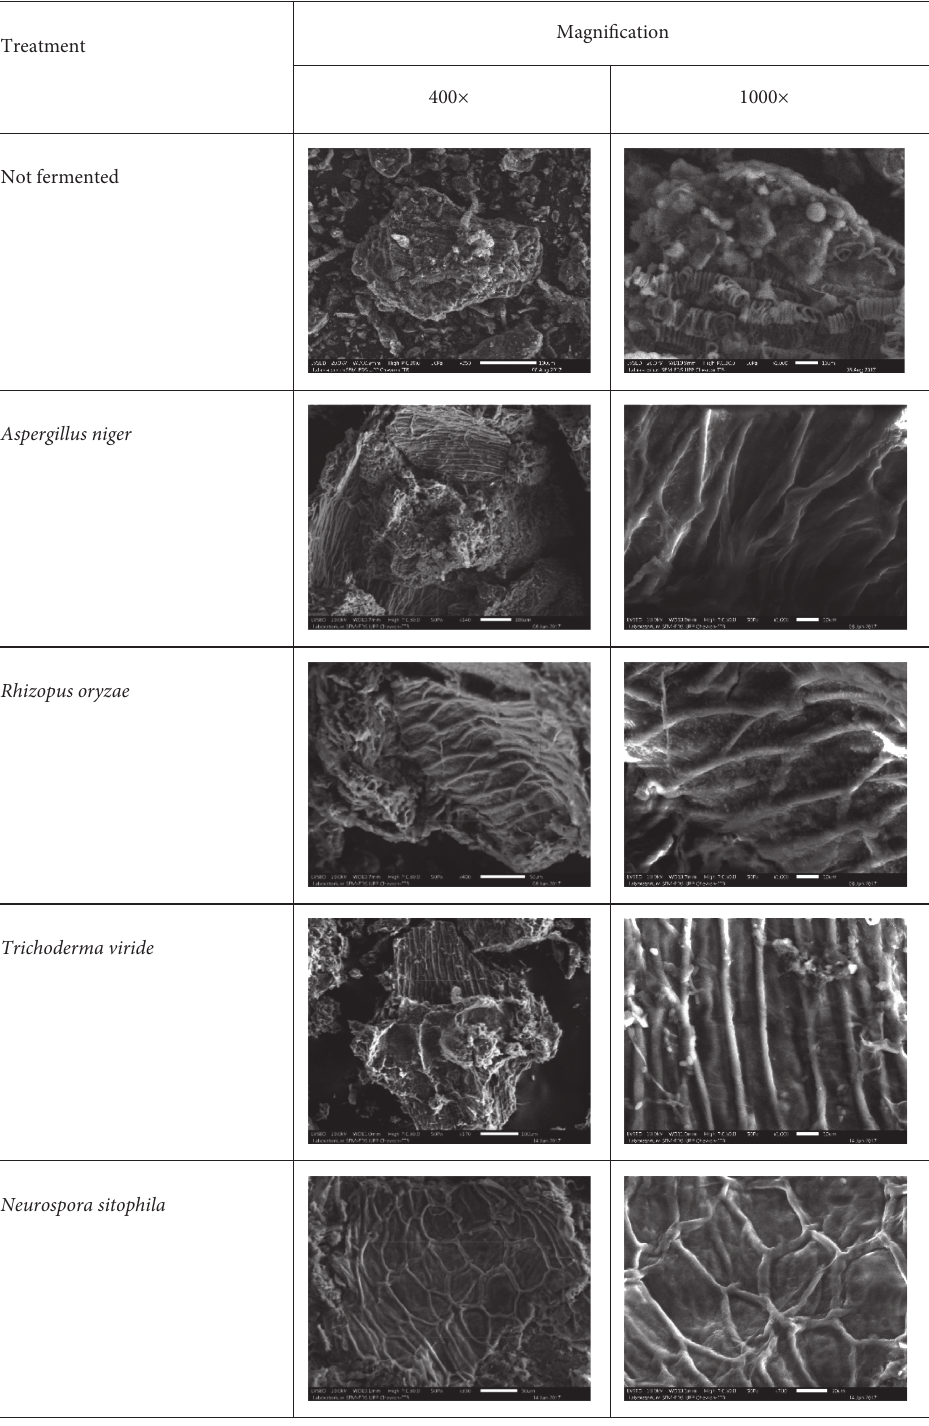
Figure 1: Microstructure of cocoa shell